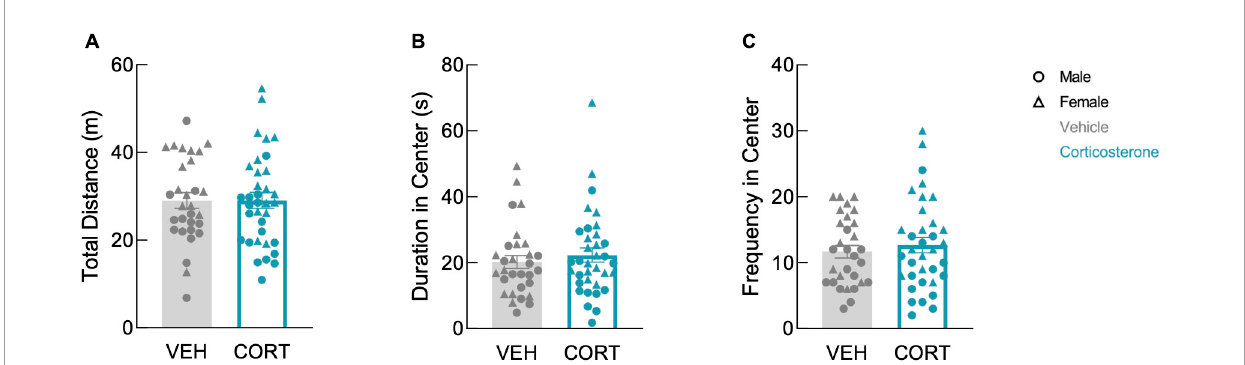
FIGURE2 Corticosterone administration did not affect locomotion or anxiety-like behavior in the open field. There was no difference in panel (A) total distance traveled, (B) total time spent in the brightly-lit center, and (C) the number of entries into the center between corticosterone-treated and control animals. In all three measures, females were more active than males (VEH: N = 30; CORT: N = 35).